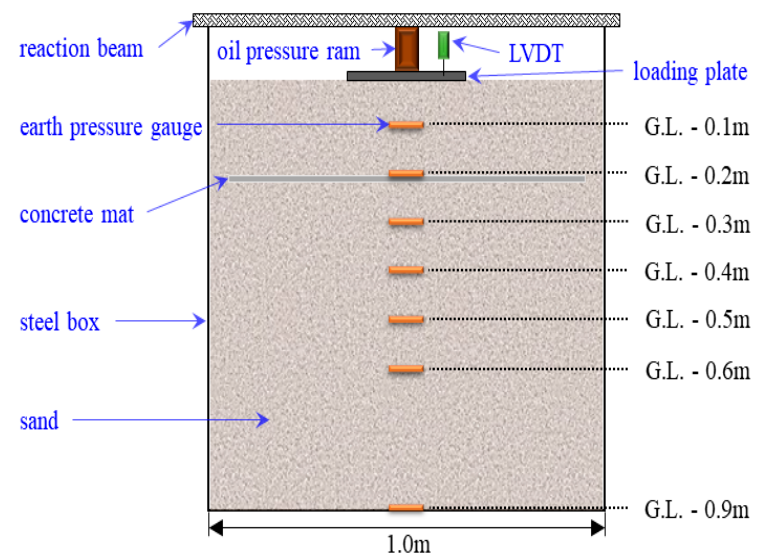
Figure 3. Schematic of the plate bearing test on a laboratory scale.